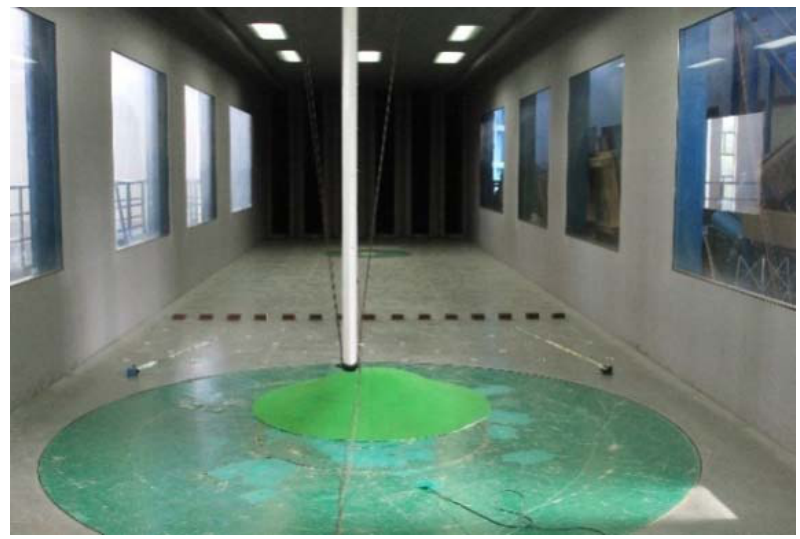
Figure 2. The hilly terrain model.